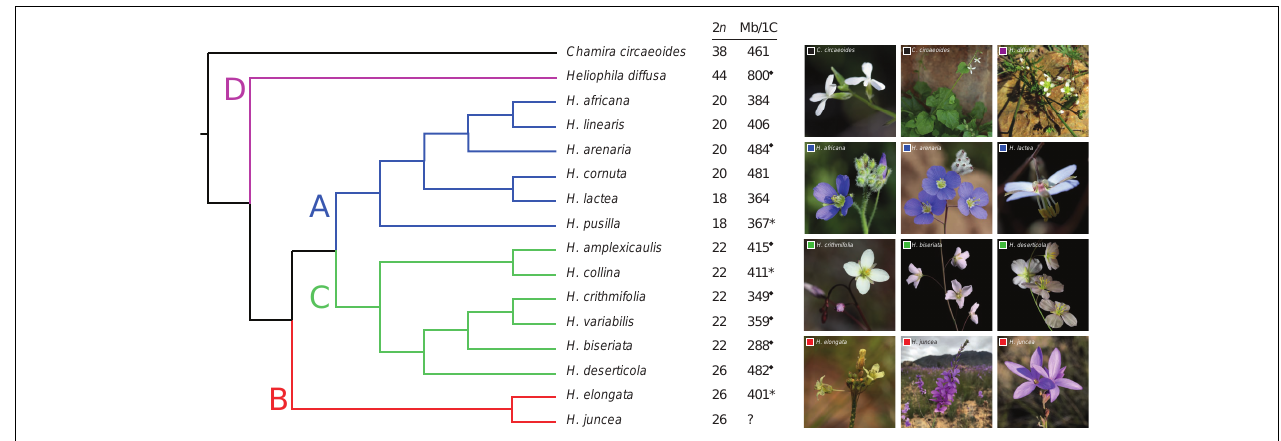
FIGURE 2 | Schematic relationships among the analyzed 15 Heliophila species and C. circaeoides based on the ITS phylogeny. Capital letters refer to four Heliophila clades. Diamond symbols indicate average C -values based on estimates for two or more populations; asterisks indicate C -values obtained by analysis of partially degraded leaf material. The original ITS phylogeny is presented as Supplementary Figure 2 . All photos by TM.